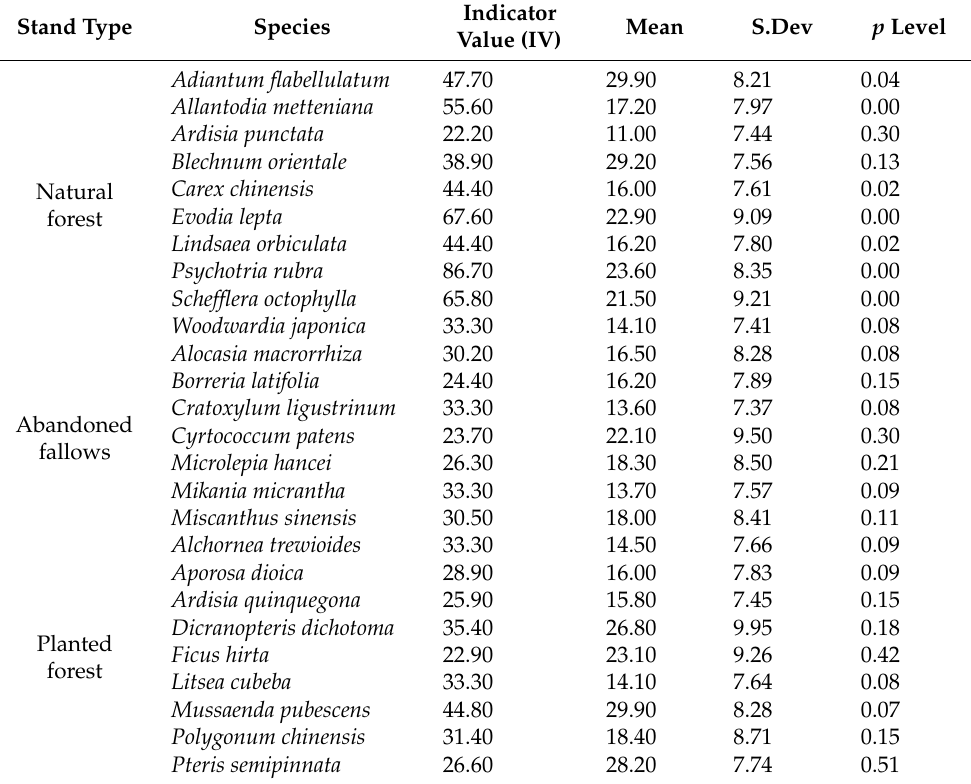
Table 4. Plant species with a significant indicator value (IV) ≥ 25 for different forest